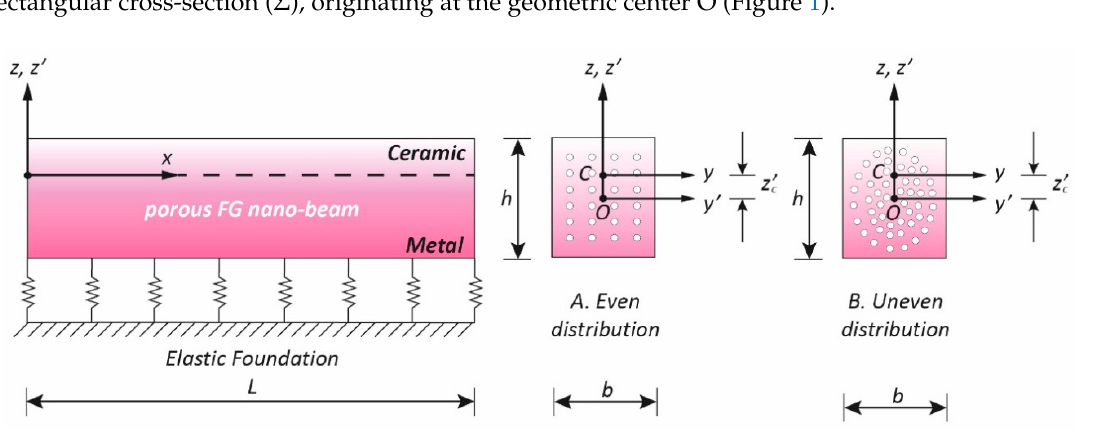
Figure 1. Coordinate system and configuration of a porous FG Bernoulli–Euler nano-beam resting on an elastic foundation: even ( A ) and uneven ( B ) porosity distributions across the thickness of the nano-beam.